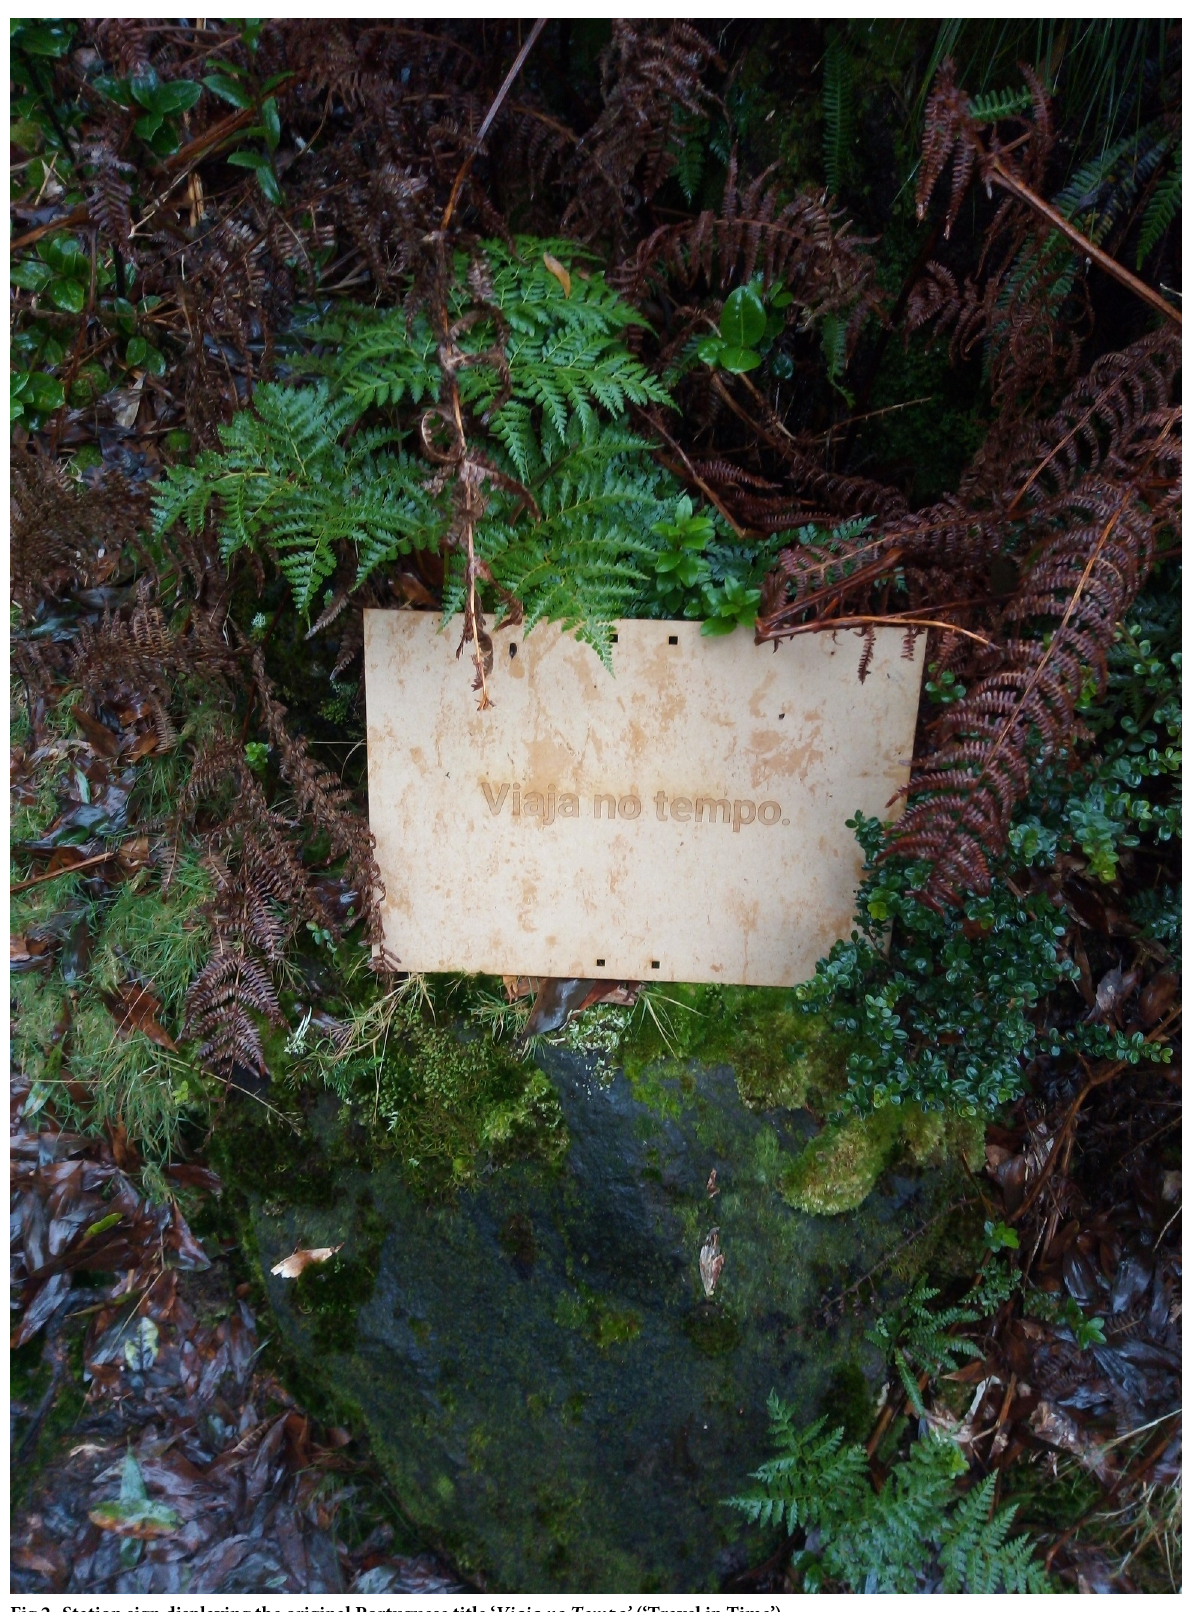
Fig 2. Station sign displaying the original Portuguese title ‘ Viaja no Tempo’ (‘Travel in Time’). https://doi.org/10.1371/journal.pone.0262853.g002 PLOS ONE | https://doi.org/10.1371/journal.pone.0262853 February 10,